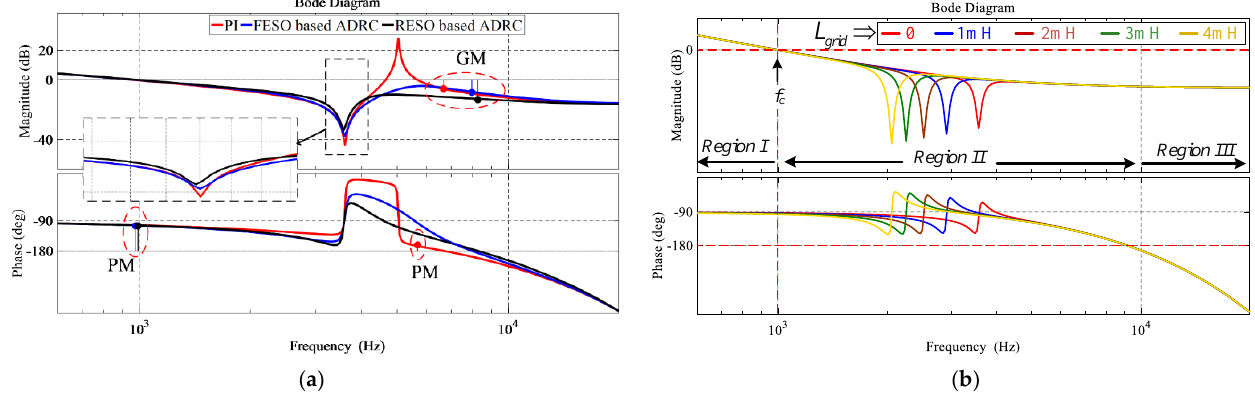
Figure 16. Loop gain frequency response characteristics ( a ) PI, FESO, and RESP-based ADRC comparison; ( b ) with the RESO-based ADRC under L grid variation.